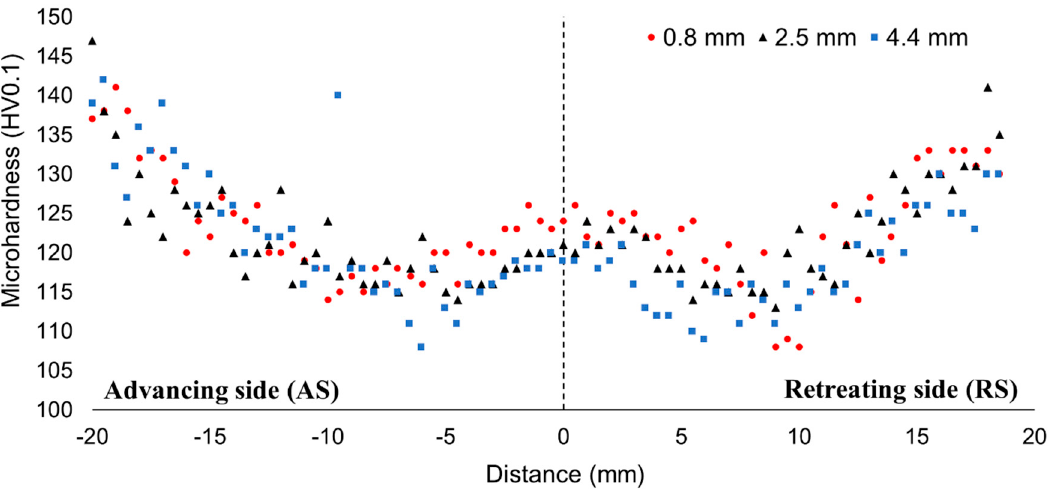
Figure 6. Microhardness profile of the welded joint cross-section.